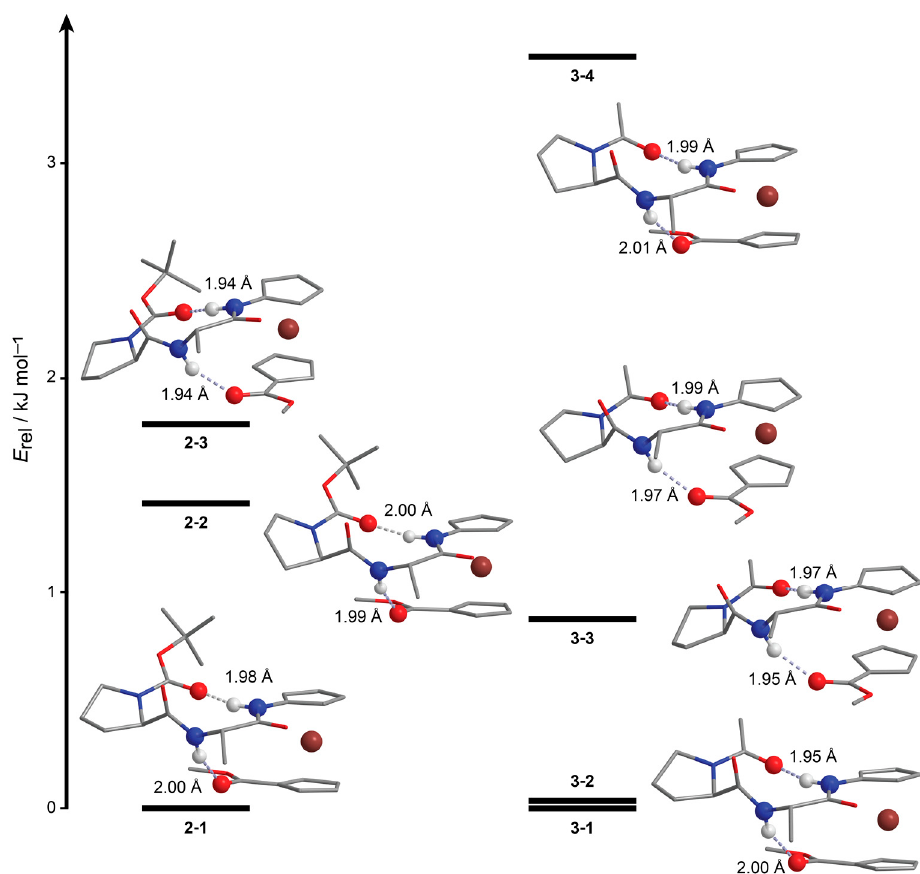
Figure 3. DFT optimized geometries of the most stable conformers of heterochiral peptides 2 and 3 . Dashed lines represent hydrogen bonds confirmed by the QTAIM analysis. Nonpolar hydrogen atoms are omitted for clarity.